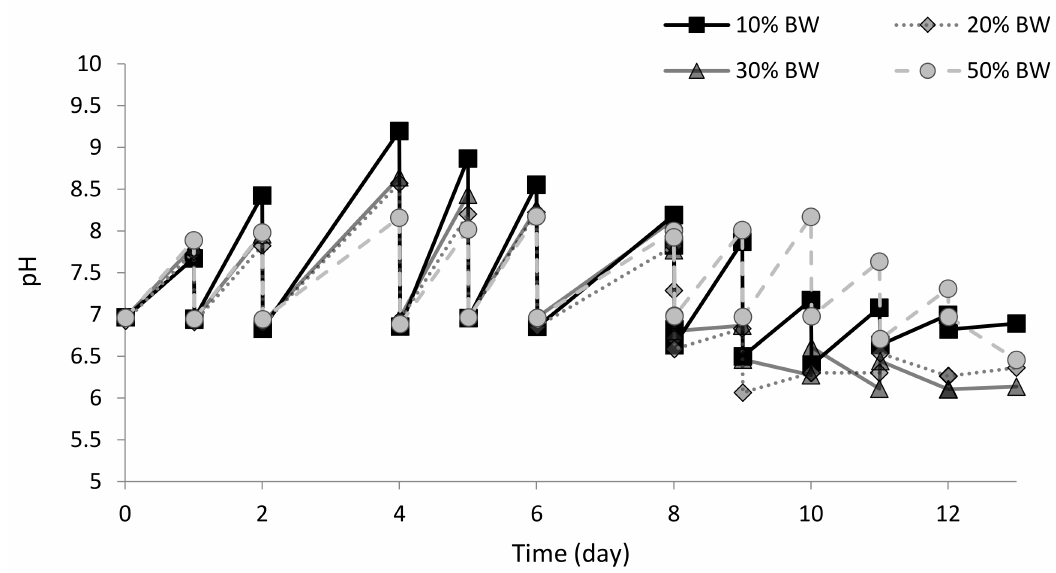
Figure 4. Fluctuations of pH in photobioreactors (PBRs) with di ff erent dilutions of blackwater (BW) and daily carbon dioxide (CO 2 ) insu ffl ation ( n =